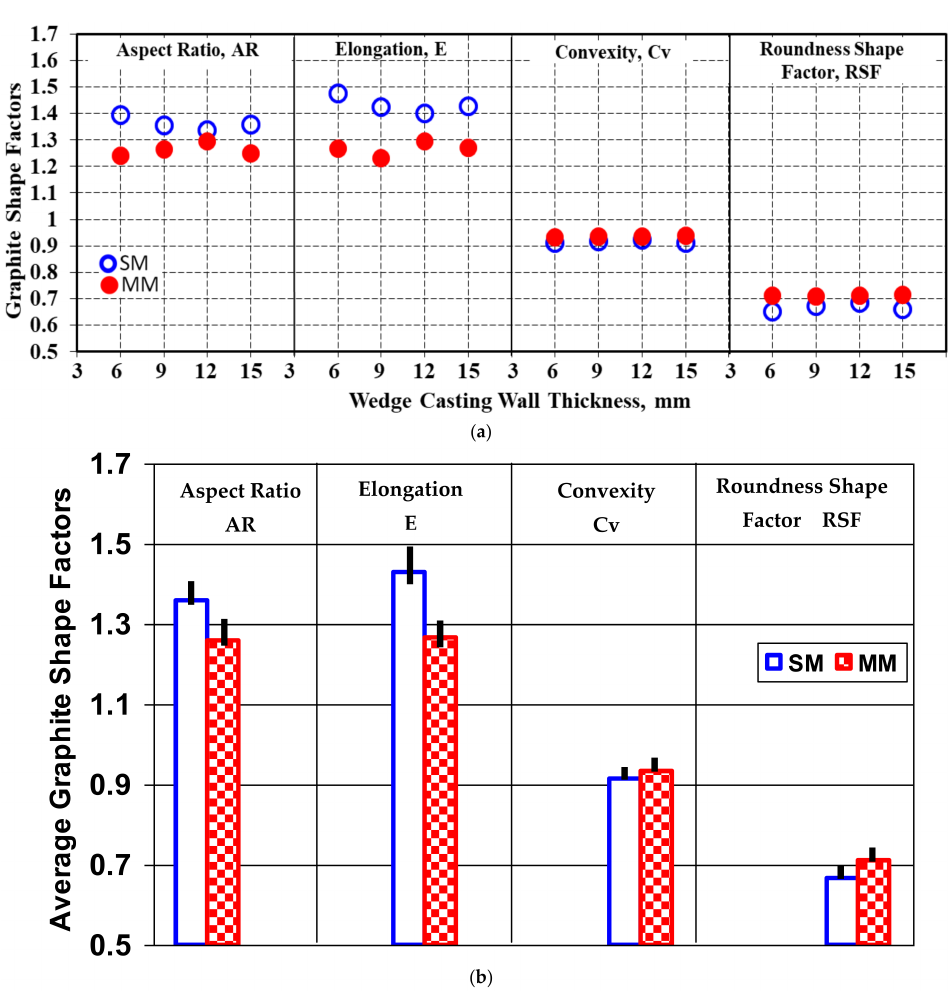
Figure 10. Influence of the mold media and wedge casting wall thickness on the level of the aspect ratio, elongation, convexity and roundness shape factor [( a ) at different wall thicknesses; ( b ) average for the wedge casting].